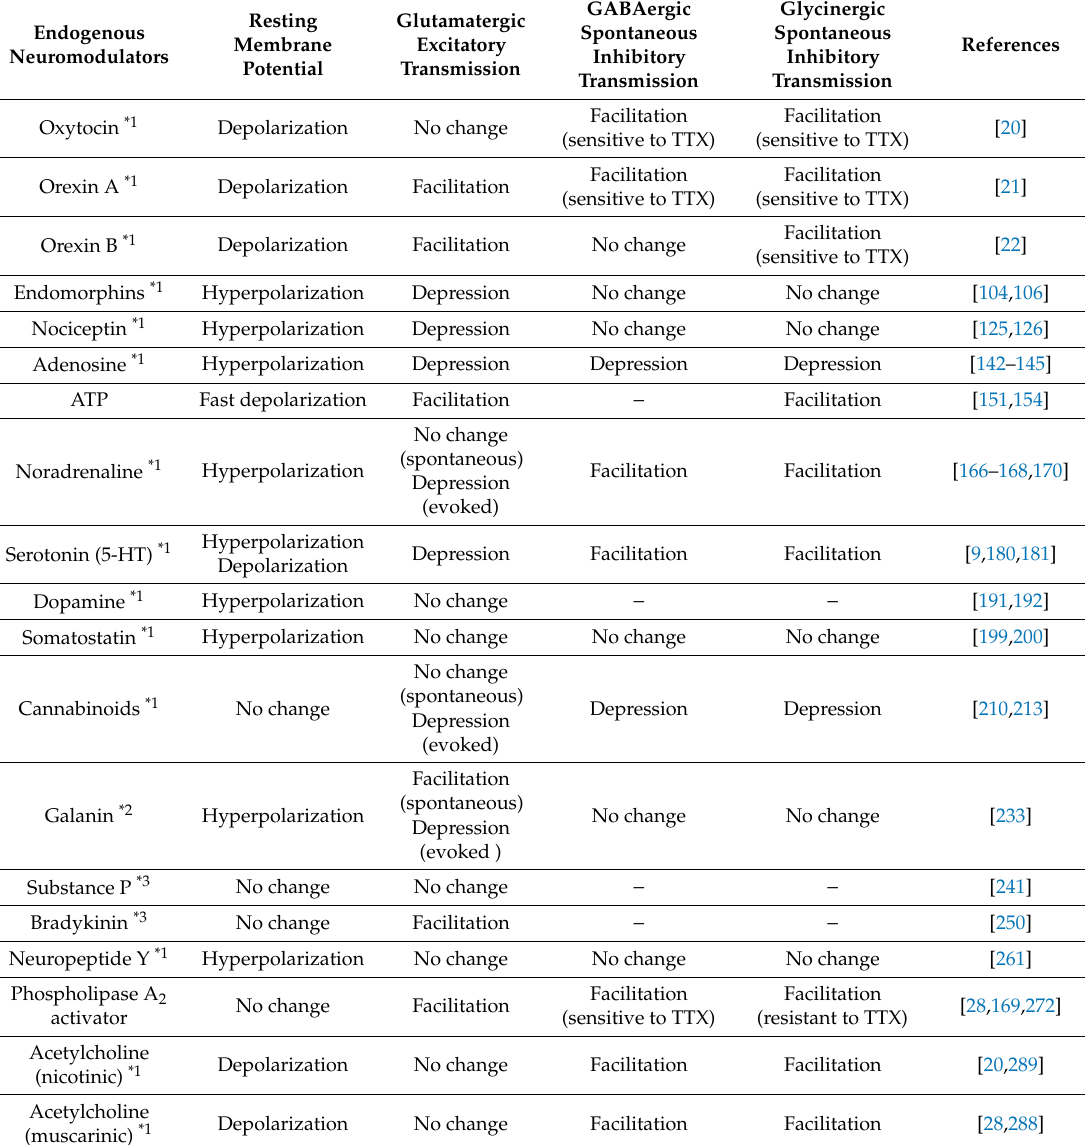
Table 1. Comparison of synaptic modulation produced by oxytocin, orexins A and B with those of other endogenous pain neuromodulators in rodent spinal lamina II